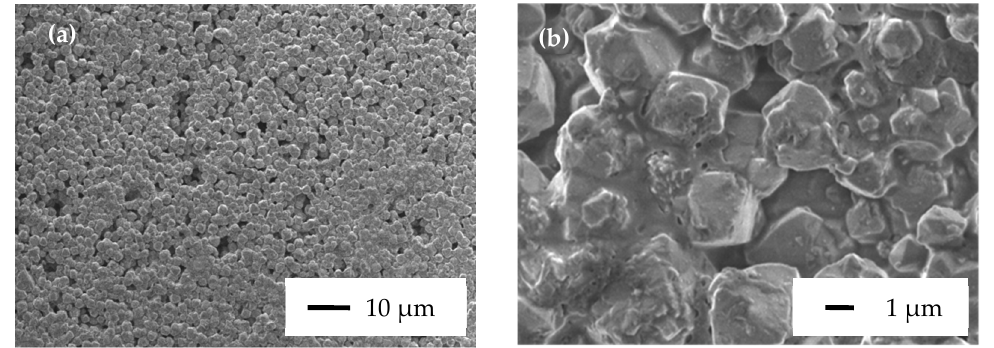
Figure 3. SEM micrographs of the zeolite FAU-HK46 coating 4 made with a zeolite content of 80 wt.% at different scales ( a ) 10 µm; ( b ) 1 µm .